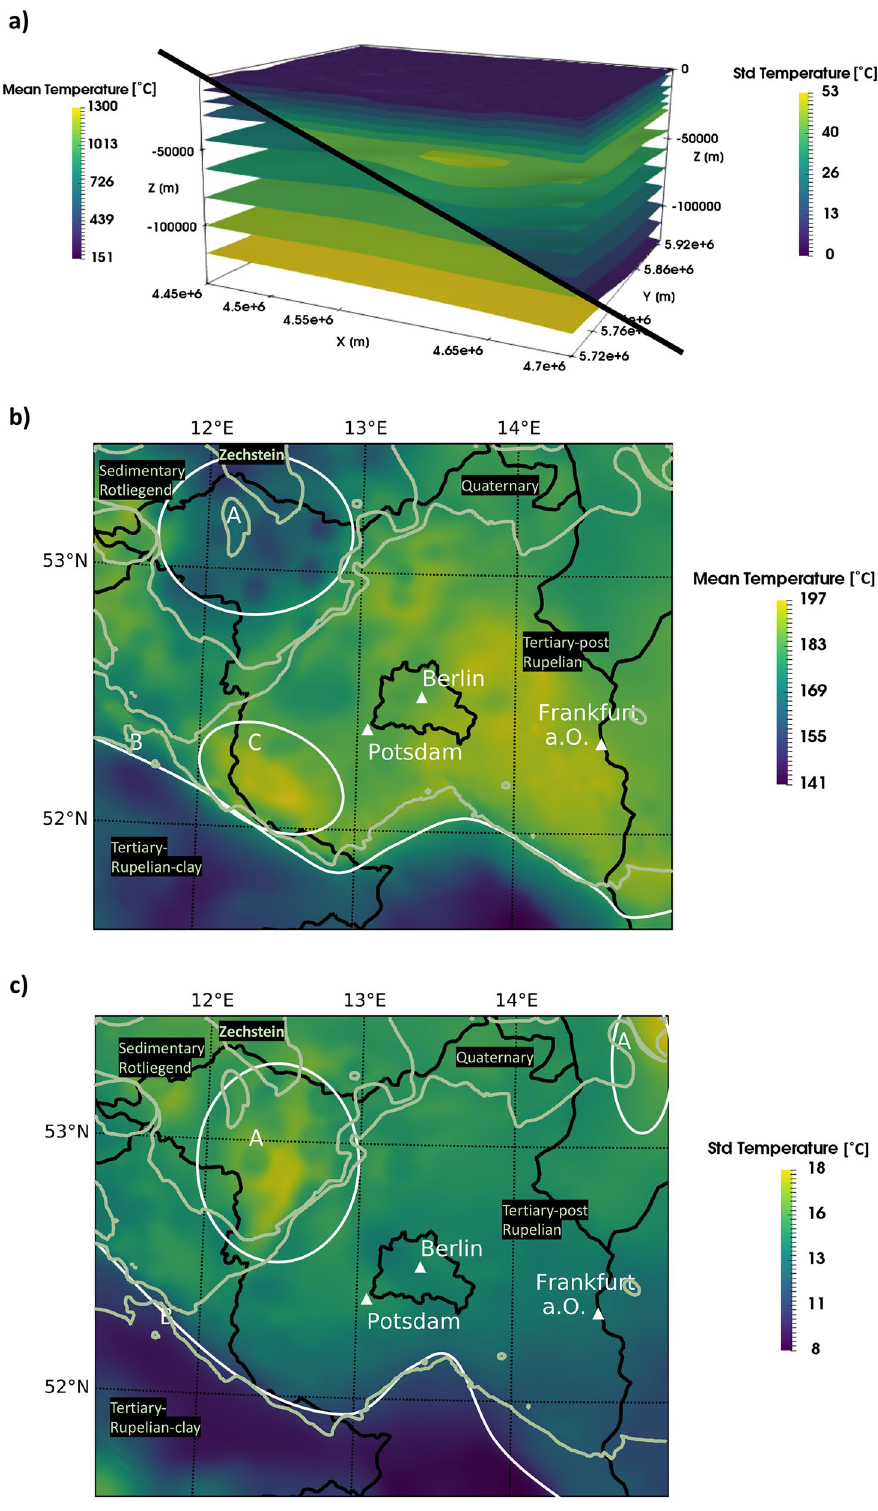
Figure 4. ( a ) Distribution of the posterior mean temperature and the posterior standard deviation of the entire Berlin–Brandenburg model. ( b ) Map of the posterior mean temperature and ( c ) posterior standard deviation at the target depth of 5 km. The light green lines in ( b , c ) indicate the boundaries of the geological layers. The maps in ( b , c ) have been generated using ParaView 36 and the Python library BaseMap 37